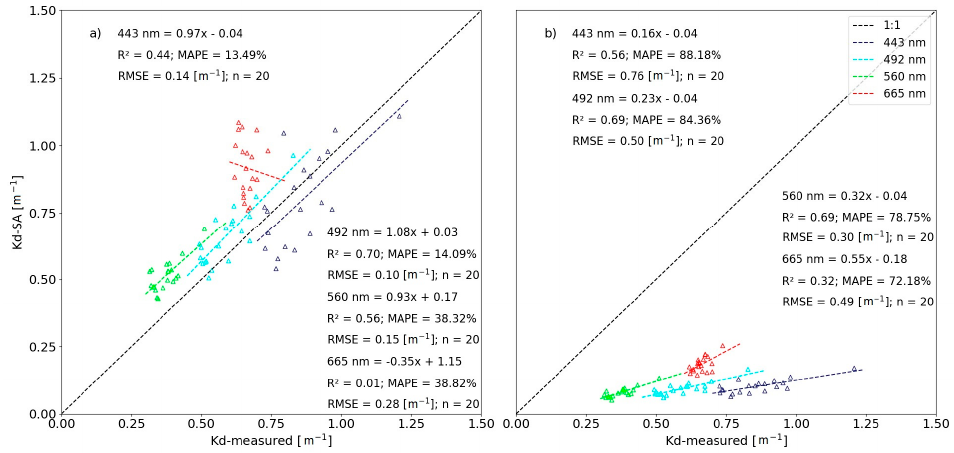
Figure 13. K d − SA ( λ ) derived from MSI bands R rs ( λ ) validations for ( a ) QAA TM at 443, 492, 560, and Figure 13 . 𝐾 (cid:3031)(cid:2879)(cid:3020)(cid:3002) (λ) derived from MSI bands 𝑅 (cid:3045)(cid:3046) (λ) validations for ( a ) QAA TM at 443, 492, 560, and 665 nm; and ( b ) QAAv6 at 443, 492, 560, and 665 nm. 665 nm; and ( b ) QAAv6 at 443, 492, 560, and 665 nm.